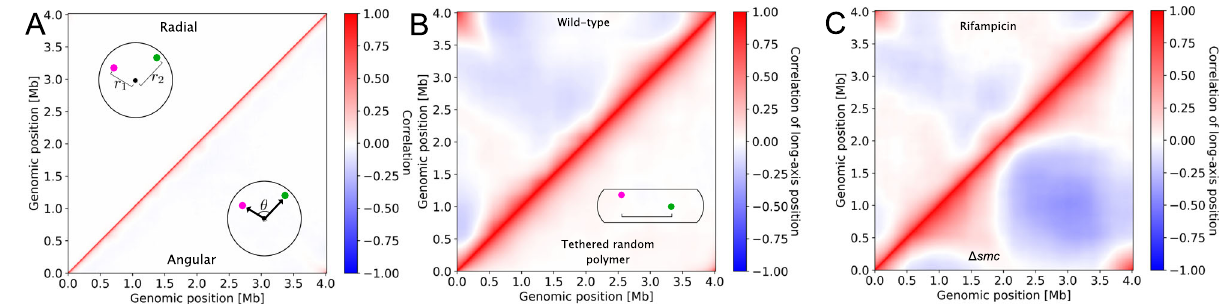
Fig. 3 MaxEnt model predicts large-scale features of chromosome organization. A Upper left corner: two-point correlations in the radial positions between genomic regions. Lower right corner: two-point correlations in angular orientations around the long axis. B Upper left corner: two-point correlations between long-axis positions for wild-type cells. Lower right corner: the same correlations for a model not constrained by Hi – C data, but with a tethered origin (tethered random polymer). C Correlations in the long-axis positions of genomic regions derived from Hi – C data 26 obtained for two modi fi ed conditions: cells treated with rifampicin to block transcription (upper left corner), and Δ smc cells (lower right corner).